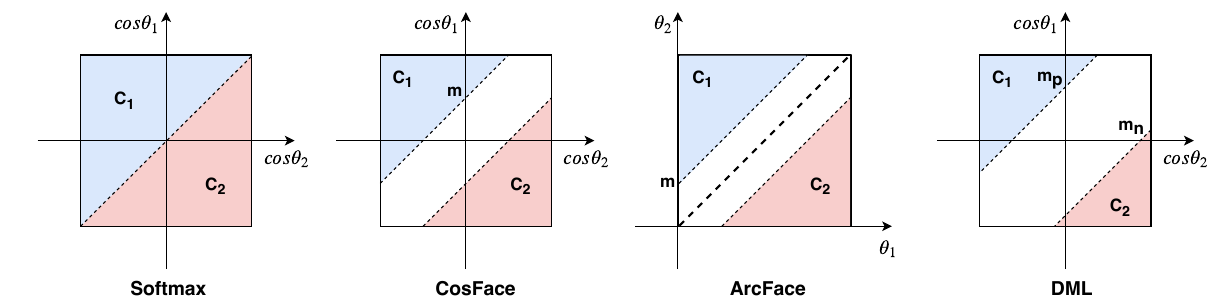
Figure 3. The decision margin of different loss functions for discriminative analysis is visualized. C 1 is a positive class and C 2 is a negative class. Blue, red, and white areas represent positive decision margin, negative decision margin, and decision limit, respectively. As can be seen, unlike other losses that consider constant margins m for the positive and negative decision margins, DML learns margins m p , m n for the positive and negative decision margins, where m n > m p